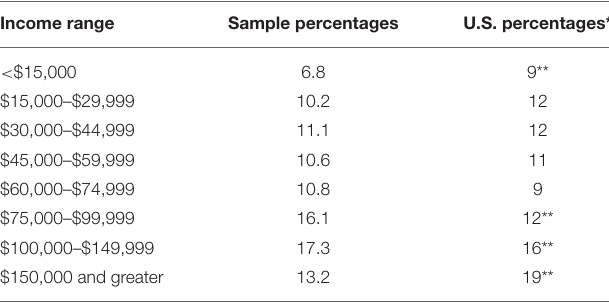
TABLE 2 | Comparisons of sample and U.S. income distributions.